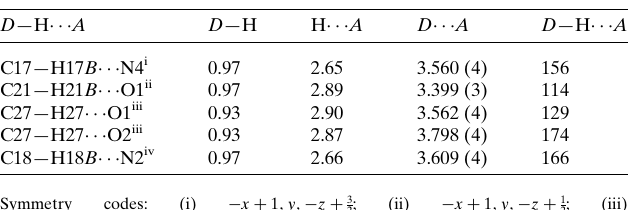
Table 1 Hydrogen-bond geometry (A˚ , (cid:2) ).